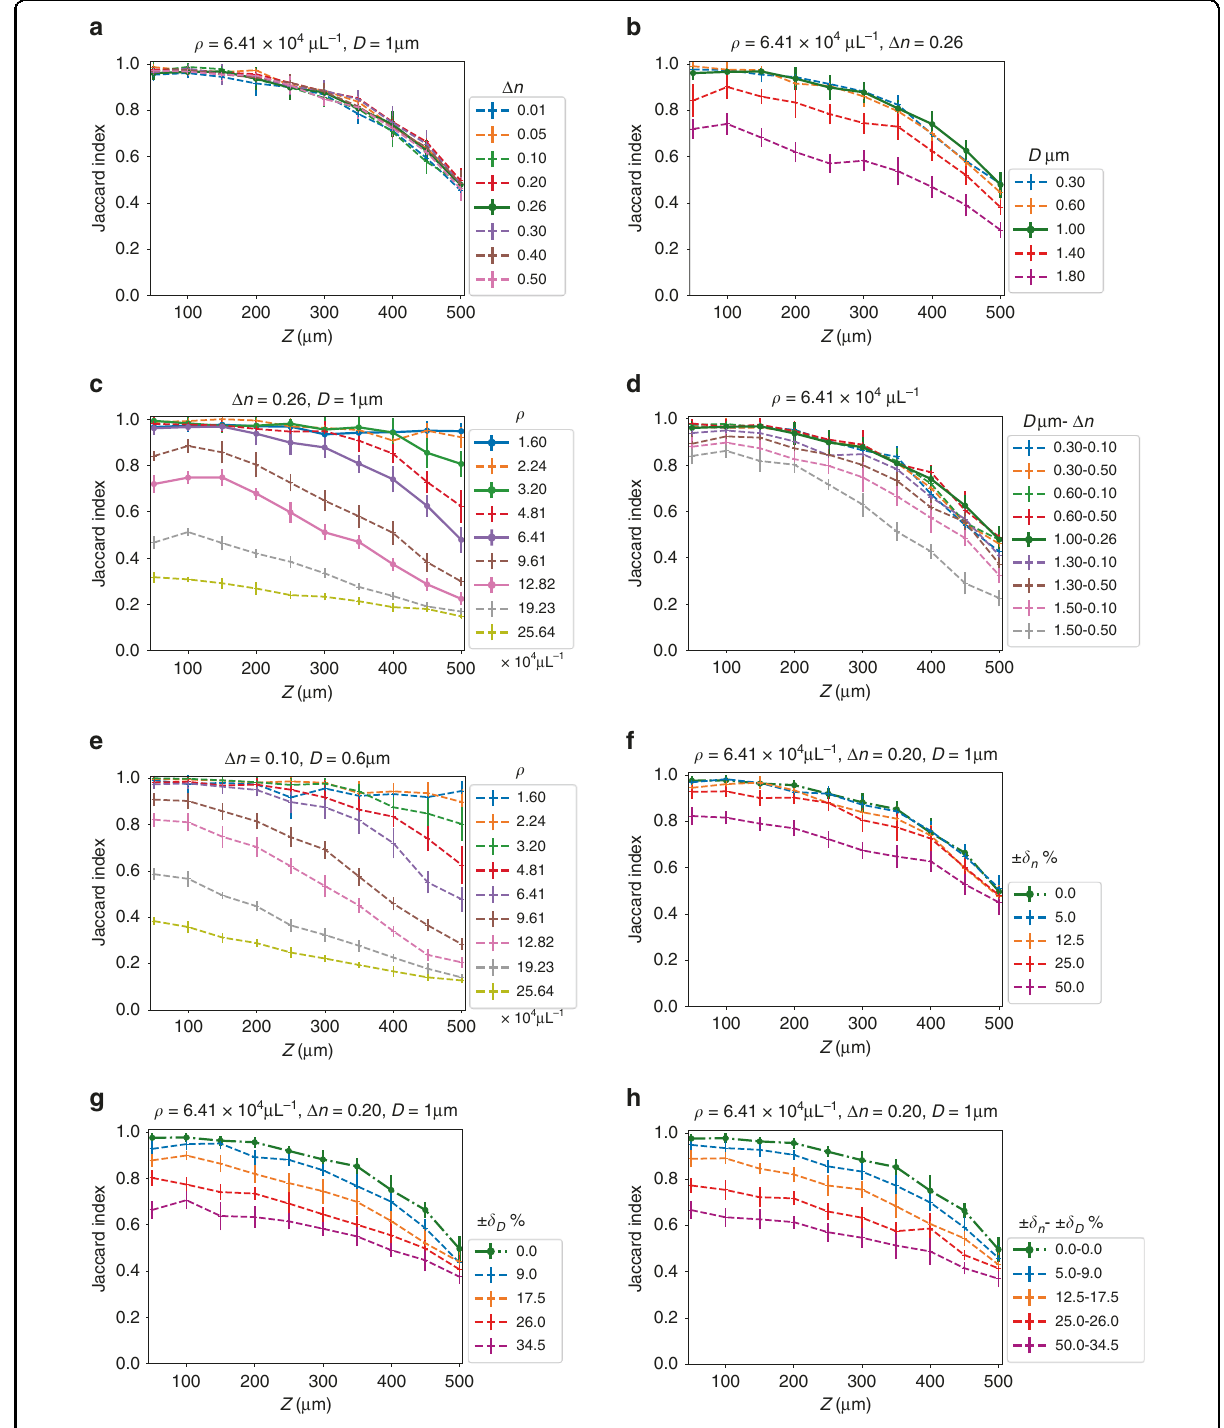
Fig. 4 Generalization of the DSN to unseen scattering conditions. The DSN demonstrates robust descattering for a continuum of scattering levels covering a wide range of refractive indices, particle sizes, and particle densities. The baseline seen cases are shown in solid lines; the unseen test conditions are in dashed lines. The testing cases include: a unseen refractive index contrast ( Δ n ); b unseen particle size ( D ); c unseen particle density ( ρ ); d unseen refractive index contrast and particle size ( D − Δ n ); e unseen refractive index contrast, particle size and density; f Uniformly distributed random refractive index contrast, ± δ n % denotes the variation range with respect to the central refractive index contrast; g Uniformly distributed random particle size, ± δ D % denotes the variation range with respect to the central size; h Uniformly distributed random refractive index and particle size (± δ n to ± δ D ). In f – h , the green dash- dotted line is the baseline unseen case at ρ = 6.41×10 4 particles μ L − 1 , with a fi xed refractive index contrast Δ n = 0.20 and a fi xed particle size D =